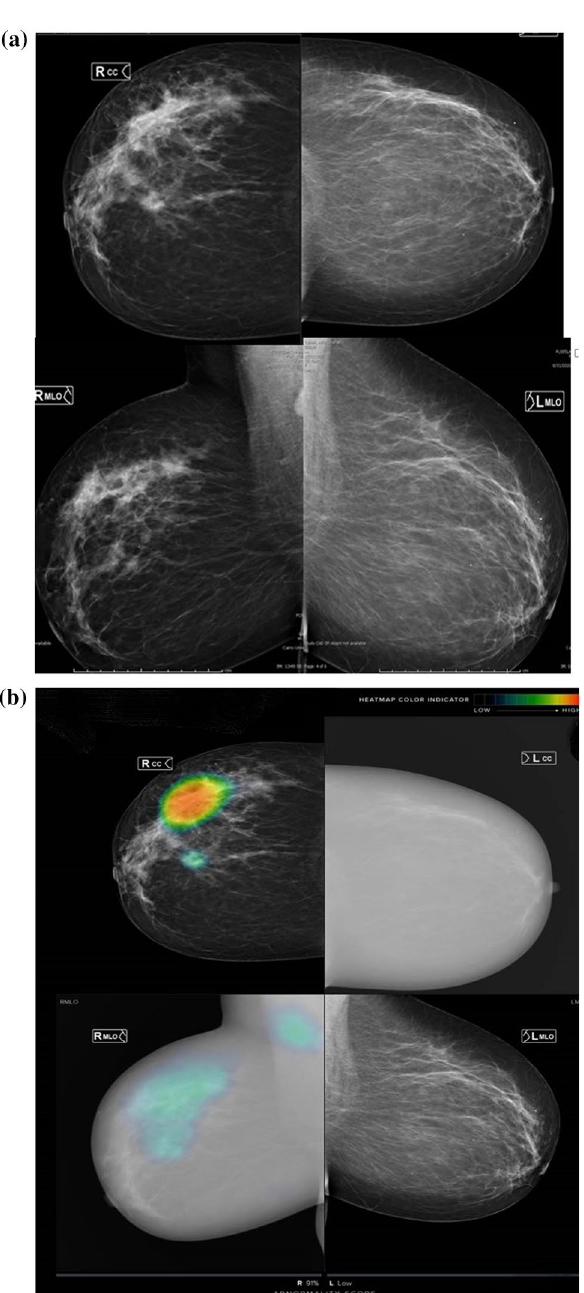
Fig. 1 A thirty-eight-year-old lady presented with a right breast lump. Mammography revealed right UOQ focal asymmetry and parenchymal distortion as well as internal amorphous calcifications ( a ). US revealed right breast UOQ prominent glandular tissue with complicated cyst ( b ). AI Software revealed no evidence of highlighted areas with PoM scoring less than 10 (low) indicating benignity ( a ). The final diagnosis was fibrocystic disease with periductal mastitis